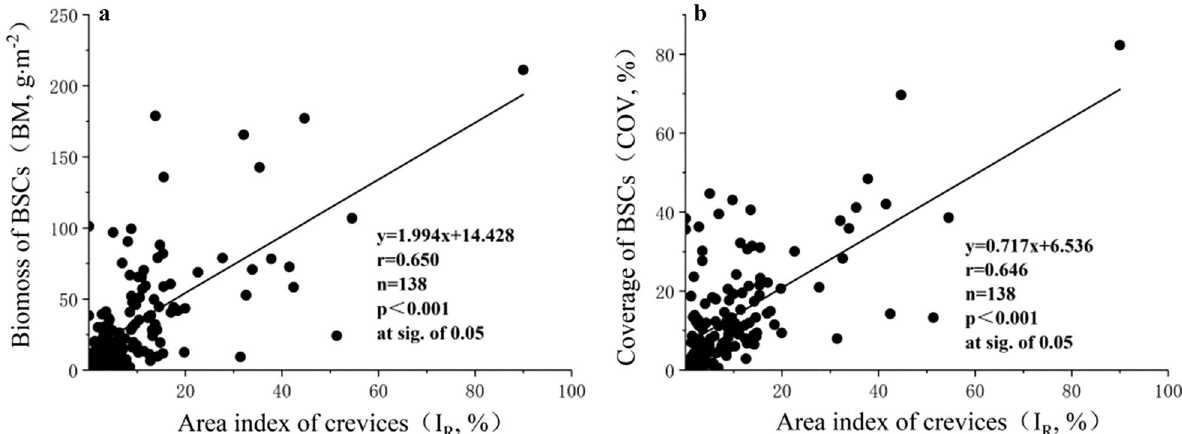
Fig. 6 Relationships between I R and BM ( a ) and COV ( b ) on RCSs. The data in Fig. 6 all come from the rock cut slopes with formation age of less than 13